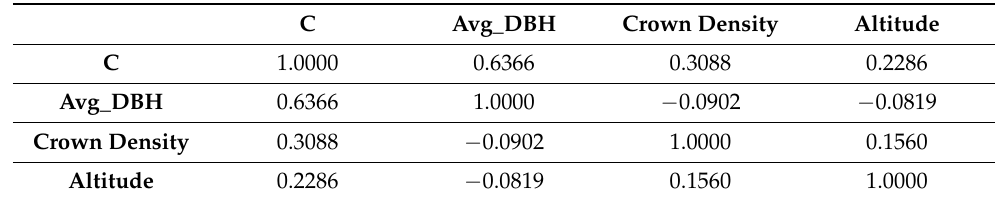
Table 5. Correlation matrices of the analyzed variables.